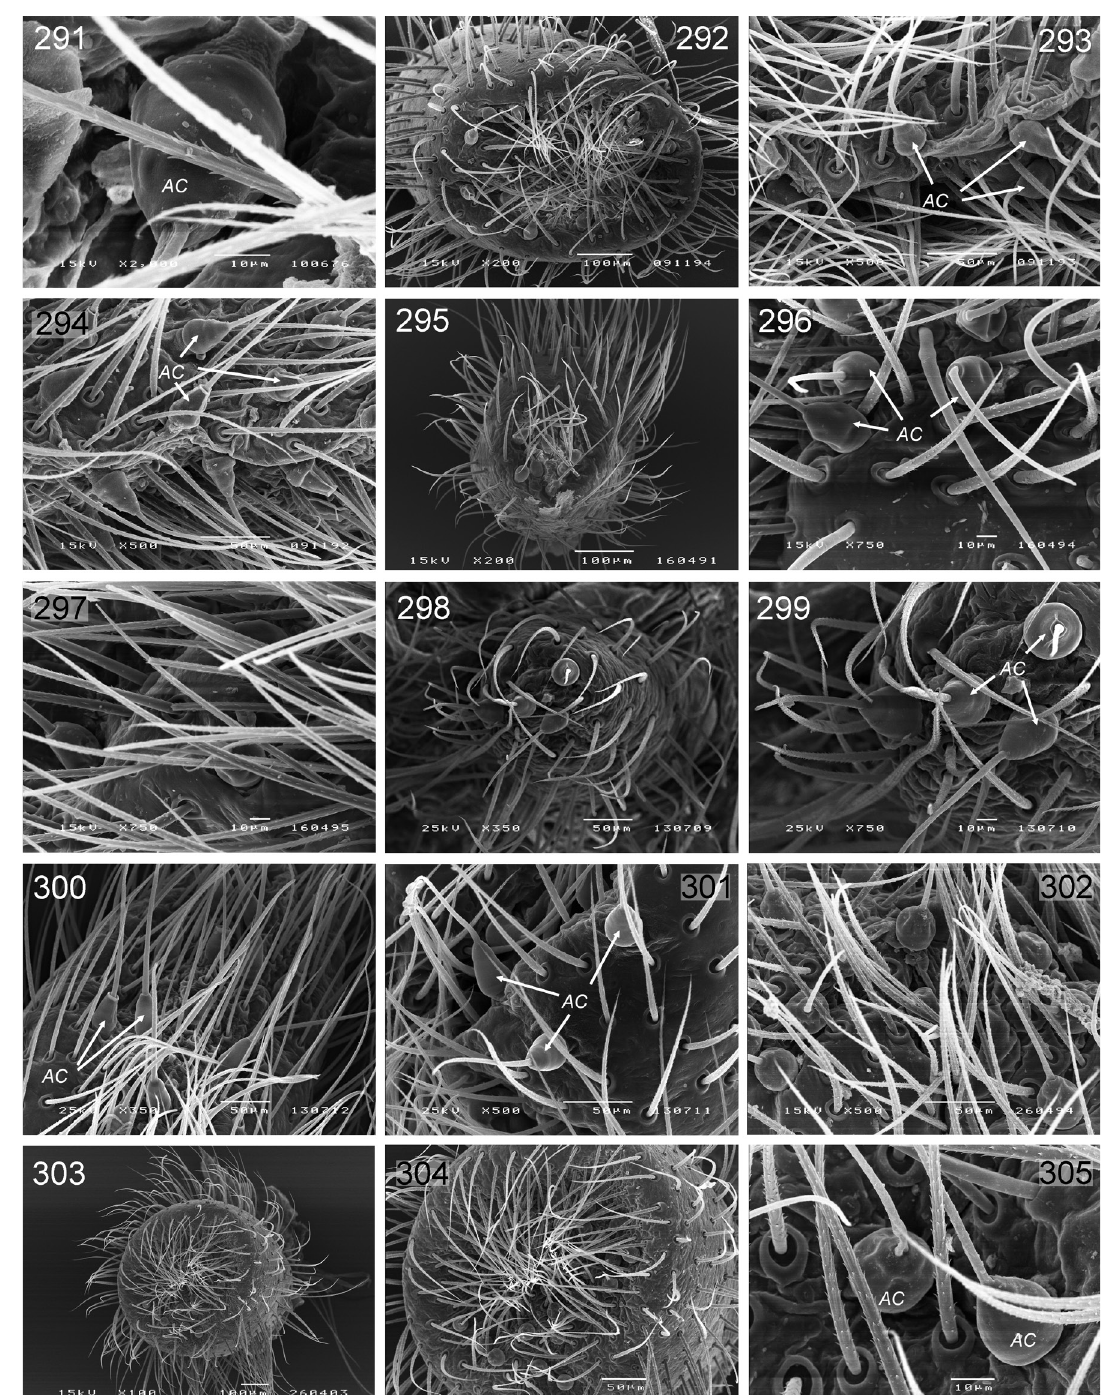
Figs 291–305. Anemesia spp., conspecific ♀♀, details of spinnerets and spigots; ventral (291, 293– 294, 296–297, 300–302) and apical (292, 295, 298–299, 303–305) views. 291 . A. pococki sp. nov. (apical spigot on PMS). 292–294 . A. oxiana sp. nov. (PMS, median and apical segments of PLS, respectively). 295–297 . A. sogdiana sp. nov. (PMS, median and apical segments of PLS, respectively). 298–301 . A. karatauvi (Andreeva, 1968) (PMS, apical spigots on PLS, median and apical segments of PLS, respectively). 302–305 . A. incana Zonstein, 2001 (apical segment of PLS; PMS with apical spigots at larger magnification, respectively). Abbreviations: see Material and